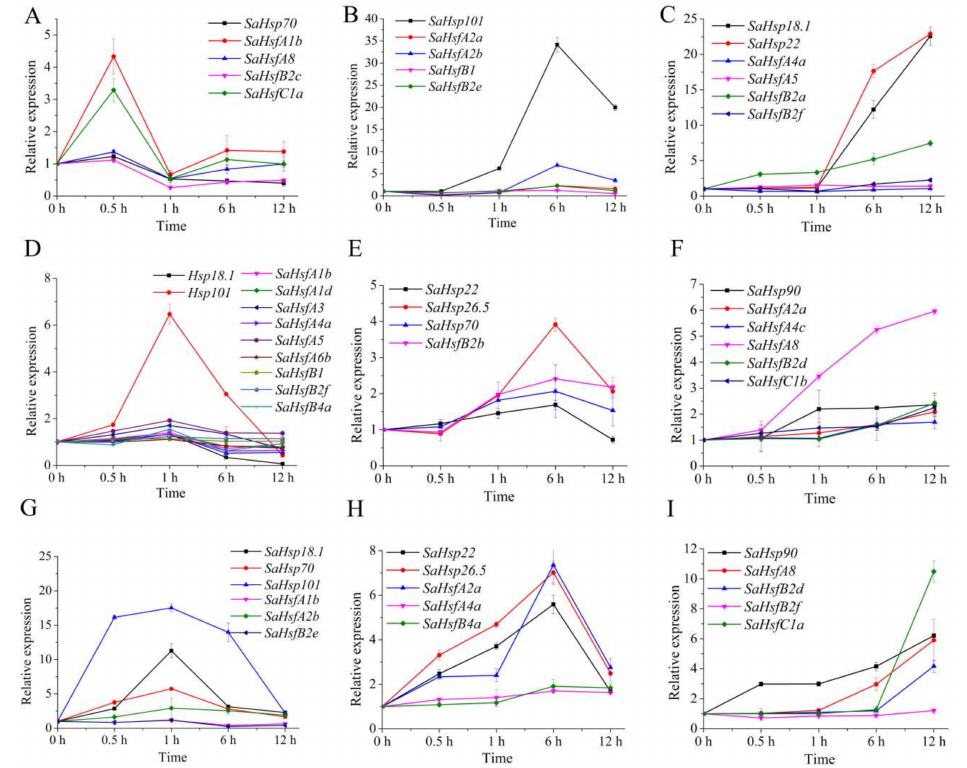
Figure 5. The expression profiles of SaHsps and SaHsfs in different tissues under Cd stress: The normalized mRNA levels without treatment were set arbitrarily to 1. ( A – C ) three similar expression patterns between SaHsps and SaHsfs in the root; ( D – F ) three similar expression patterns between SaHsps and SaHsfs in the stem; ( G – I ) three similar expression patterns between SaHsps and SaHsfs in the leaf. Bars indicate means ± standard deviations (SDs) of at least three independent biological